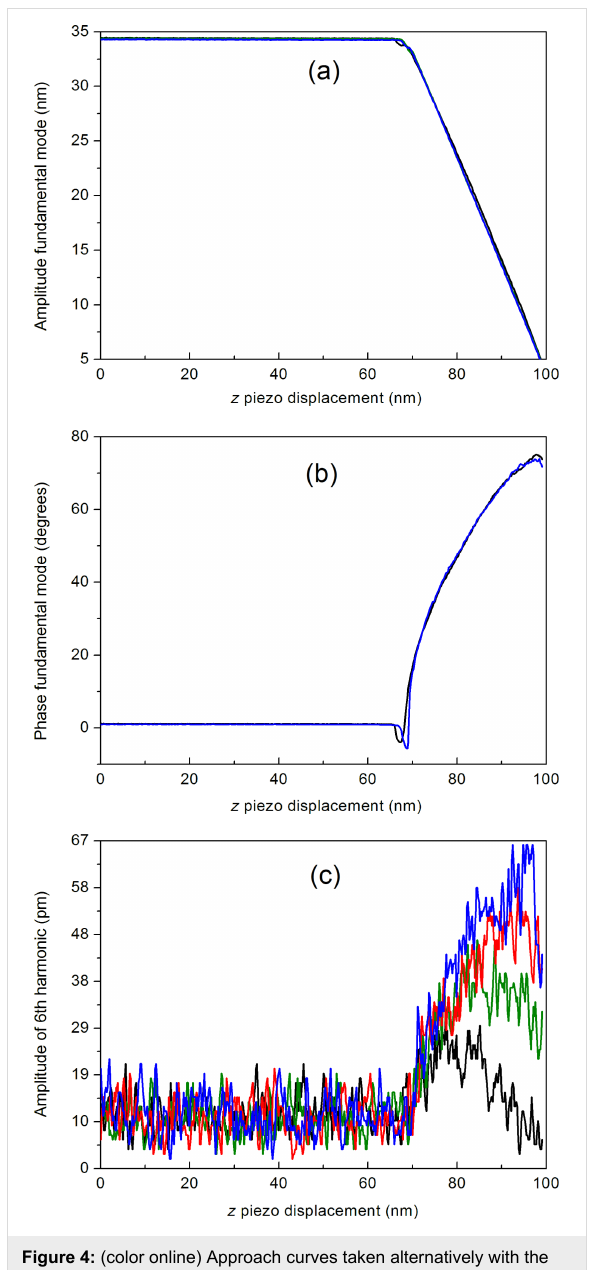
Figure 4: (color online) Approach curves taken alternatively with the acquisition of topographic, phase and amplitude images. (a) Ampli- tude of the fundamental mode, (b) phase of the fundamental mode and (c) amplitude of the 6th harmonic. Experiments have been performed with a nominally k c ≈ 44 N/m rectangular AFM cantilever with f 0 = 293 kHz on silicon surfaces and A 1 = 34 nm.